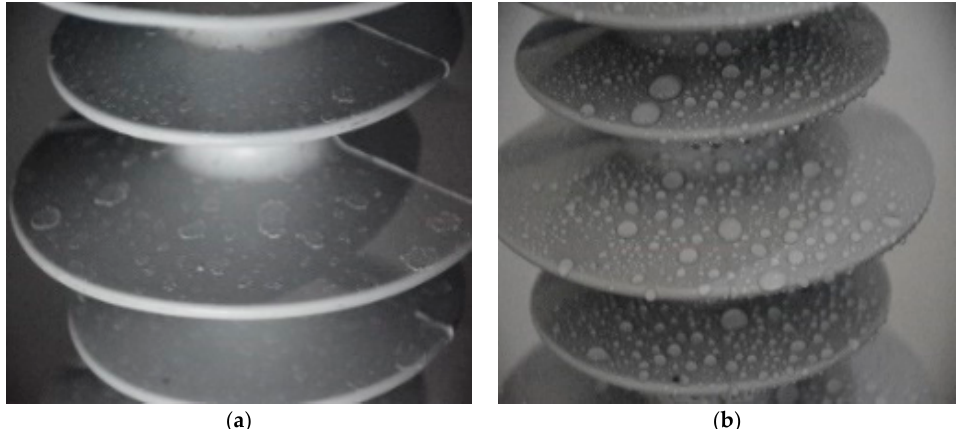
Figure 7. Insulators are subjected to salt pollutants in ( a ) dry and ( b ) wet conditions.